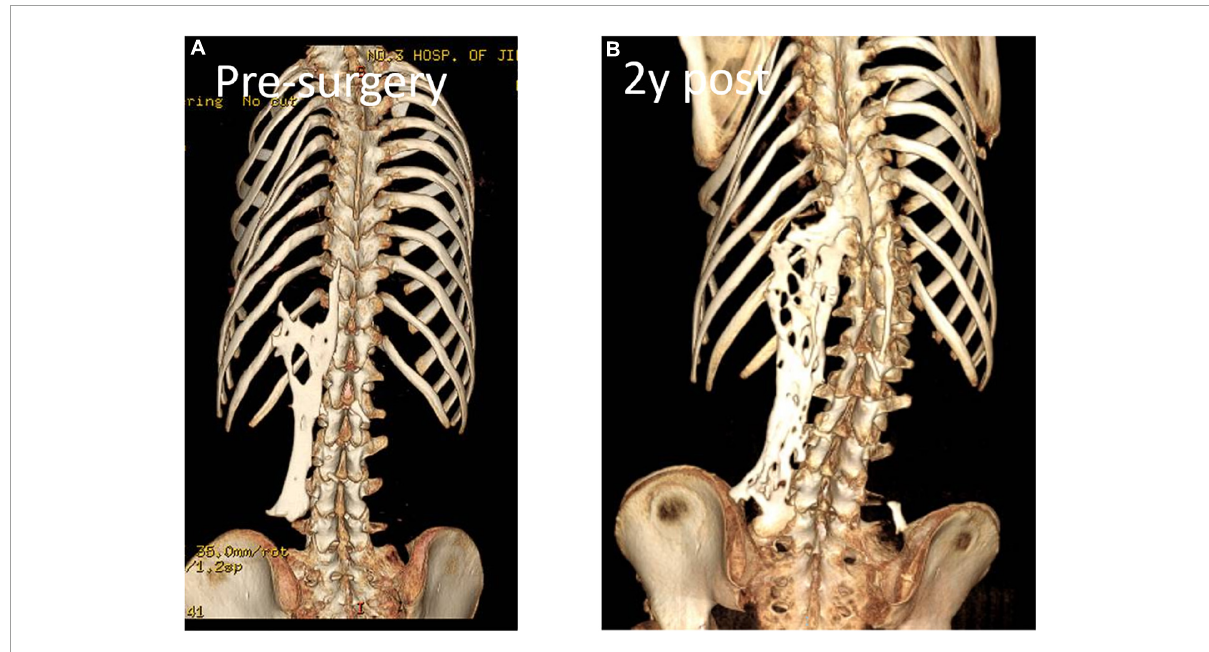
FIGURE5 Computed tomography revealed spontaneous cervical fusion, heterotopic ossification of the left dorsal fascia causing scoliosis, and developmental deformity of the right chest